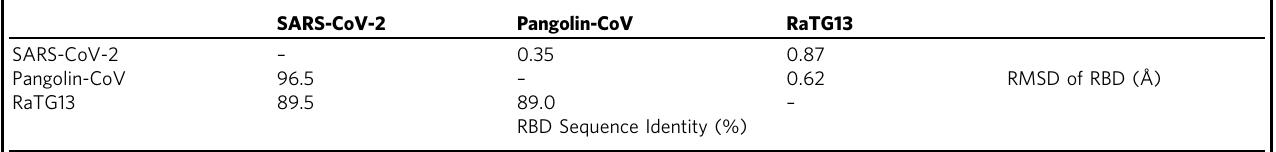
Table 2 Comparison of RBD sequence identity and RMSD of atom positions.